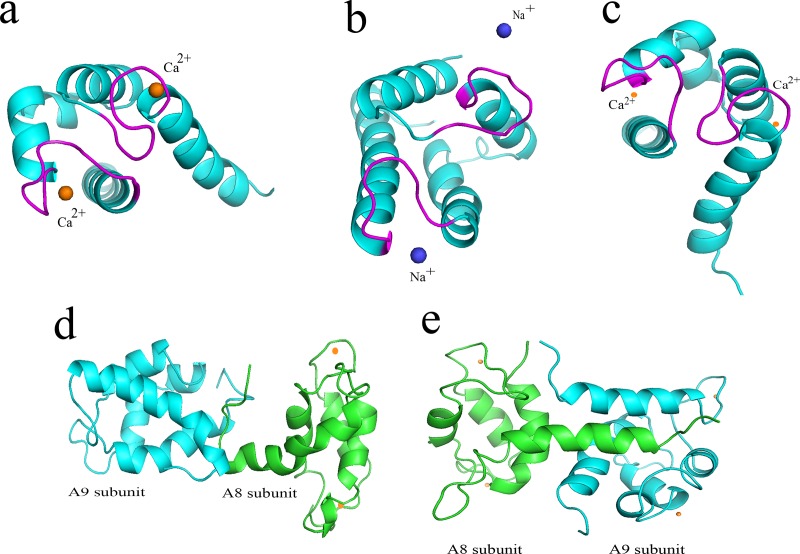
The 3D structure of the (a) A9 in presence of Ca2+, (b) A9 in presence of Na+ (c) A8 in presence of Ca2+ (d) A8/A9 complex in presence of Na+ (e) A8/A9 complex in presence of Ca2+.